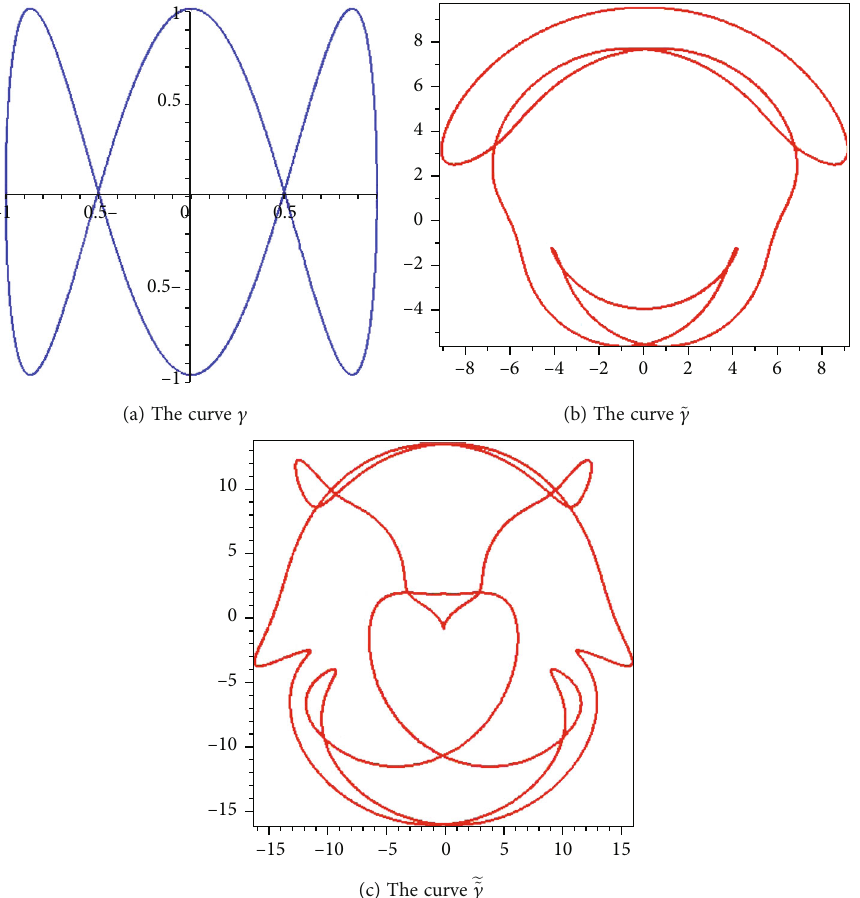
Figure 1: The curve γ and its resulting f